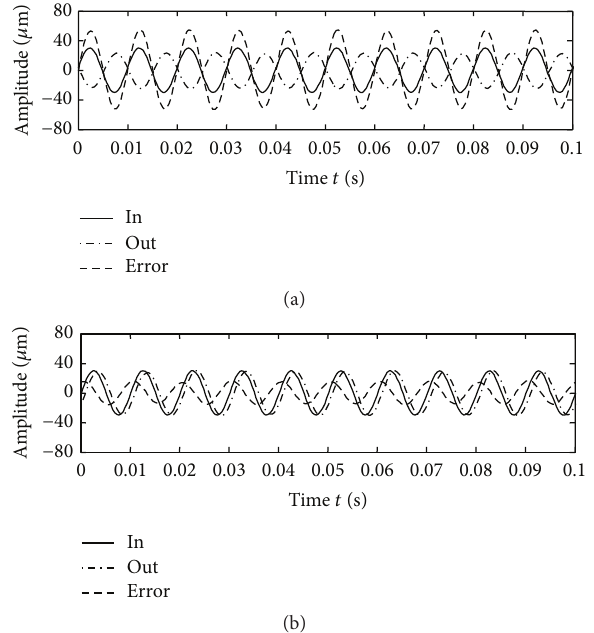
Figure 6: (a) PID 100Hz. (b) PID + ZPETC 100Hz.